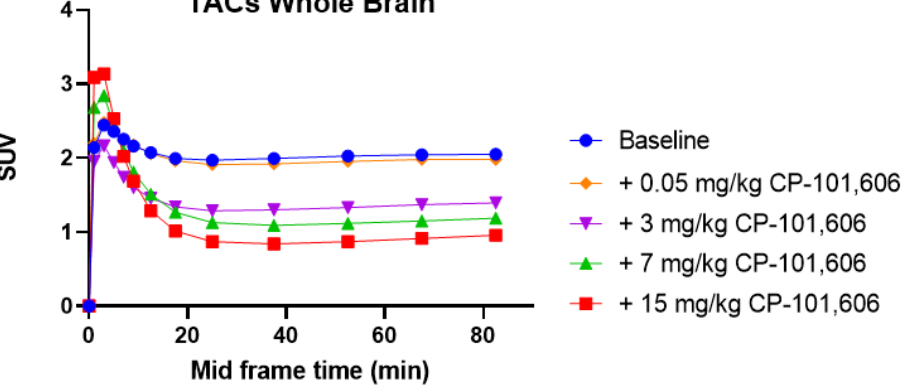
Figure 3. Time activity curves (TACs) of Wistar rat brain uptake of the σ1R tracer [ 18 F]fluspidine under baseline and blockade conditions using the GluN1/2B antagonist CP-101,606 (0.05, 3, 7 and 15 mg/kg). Standard uptake values (SUVs) are averaged from 0–90 min.